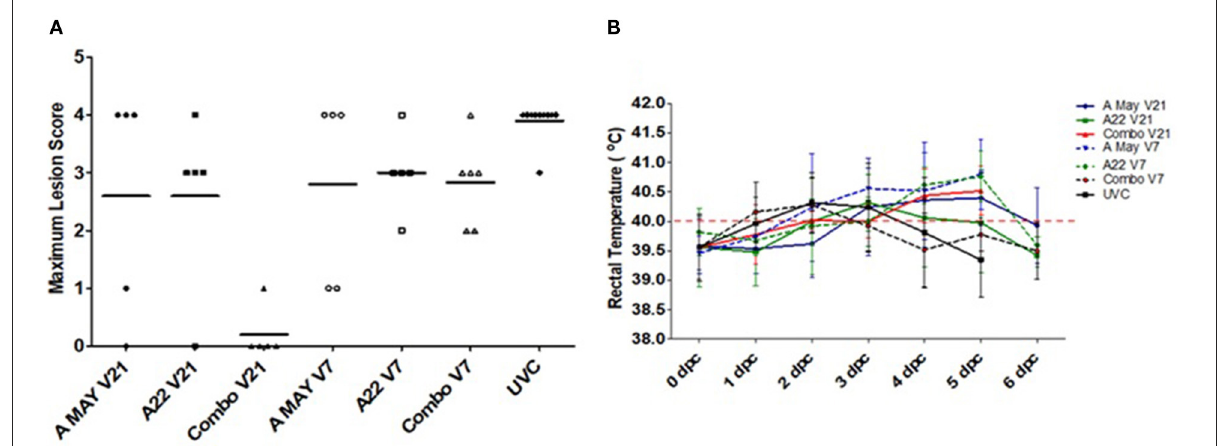
FIGURE1 Lesion scores and rectal temperatures. (A) Maximum lesion scores in pigs challenged with A/Asia/SEA-97 variant virus post-vaccination. Horizontal lines indicate the group mean scores. (B) Average rectal temperatures in pigs vaccinated and challenged during the experiment. Temperatures > 40 ◦ C were considered Horpyrexia (red dotted